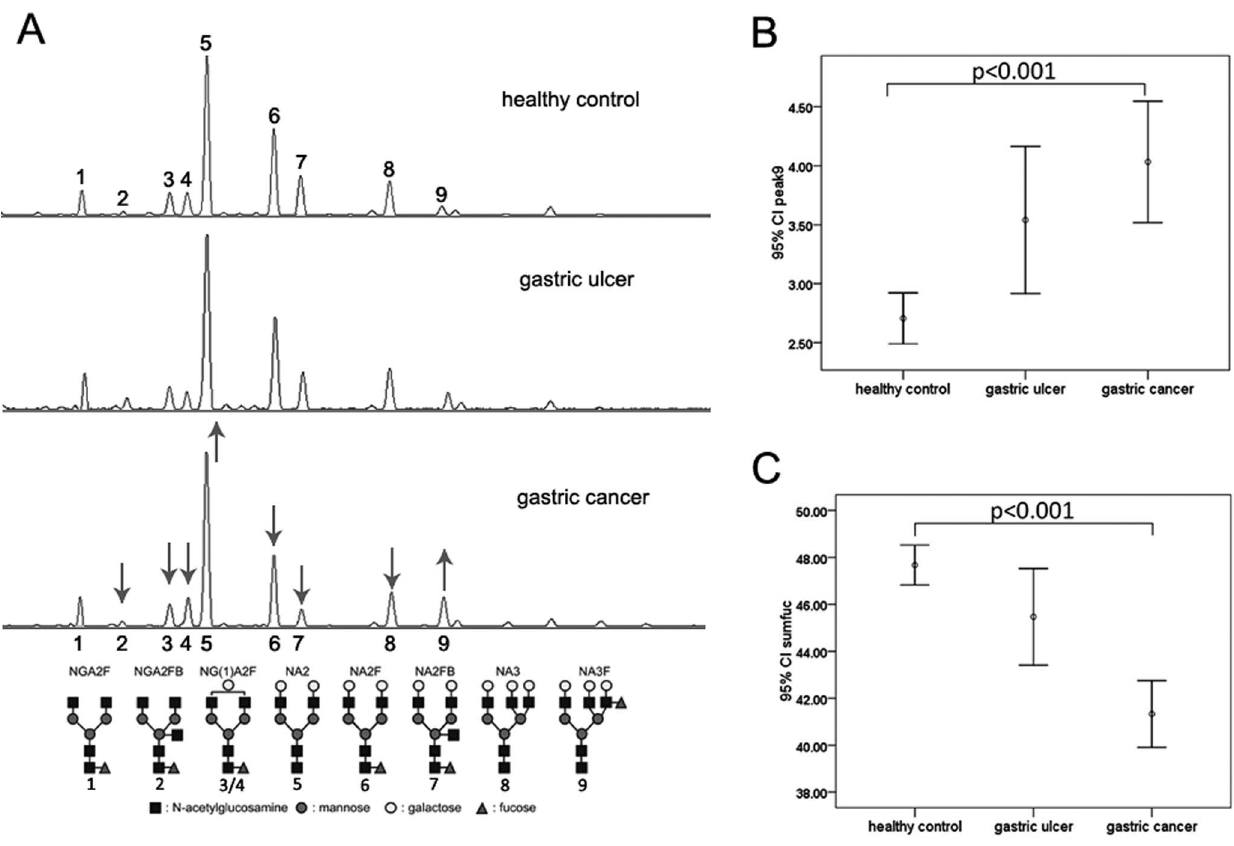
Figure 1. Typical desialylated N-glycan profiles from total serum protein and N-glycan values differ significantly among healthy control, gastric ulcer and gastric cancers. (A) The three panels (from top to bottom) are typical serum N-glycan profiles from healthy control, gastric ulcer and gastric cancers. Nine major peaks can be identified. The structures of the N-glycan peaks are shown below the chart. Levels in peaks 5 and 9 are elevated (up arrows), and levels in peaks 2, 3, 4, 6, 7 and 8 are decreased (down arrows) in gastric cancer compared with that in healthy and disease controls. Peaks 1, 2, 3, 4, 6 and 7 are core-fucosylated glycans. (B) The value of peak9 (branching a -1,3-fucosylated triantennary N-glycan, NA3FB) is elevated sequentially from healthy control, gastric ulcer to gastric cancer (P , 0.001), Error bars represent 95% confidence intervals (95%CI) for means. (C) The value of sumfuc is decreased in gastric cancer (P , 0.001). Sumfuc indicates the total abundance of core-fucosylated structure glycans (peaks 1, 2, 3, 4, 6 and 7). Error bars represent 95%CI for means.